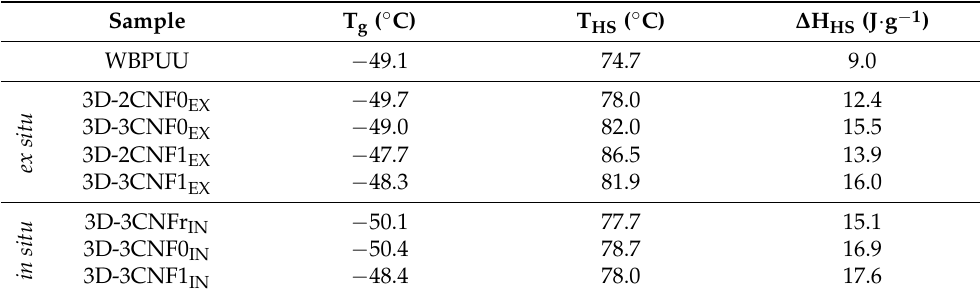
Table 4. Thermal properties observed from the DSC curves for 3D-printed parts obtained from WBPUU/CNF inks.